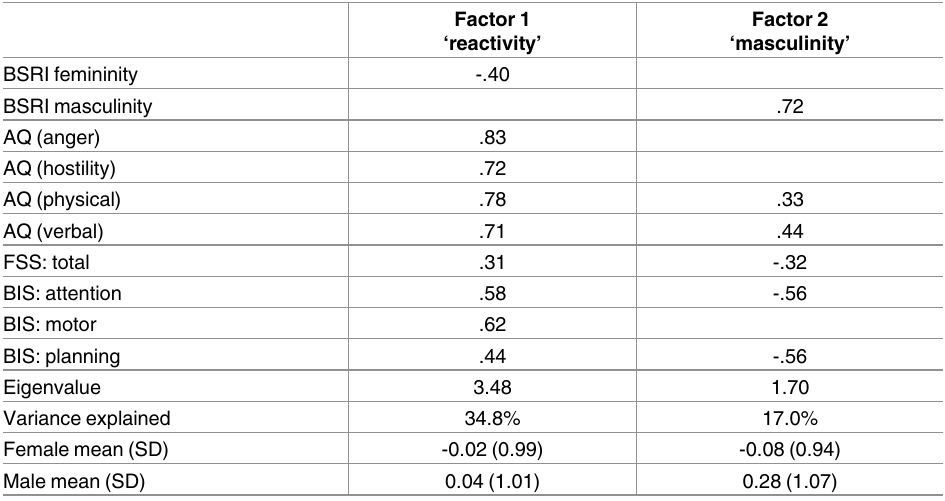
Table 2. Factor structuresand sex differences in outcome